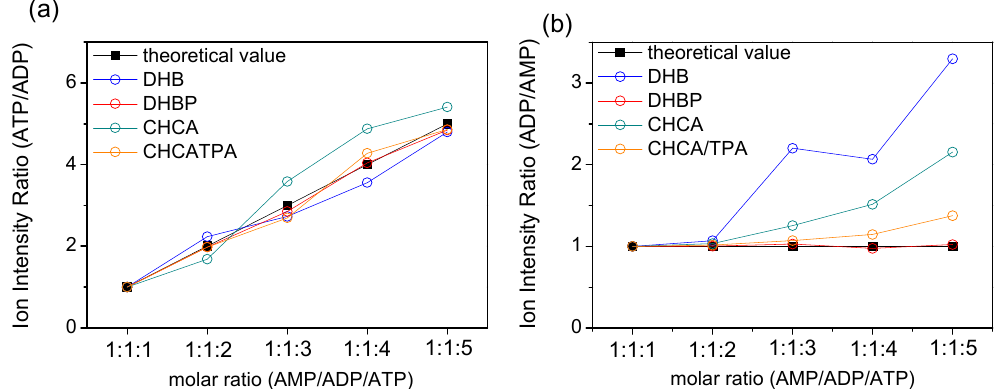
Figure 5. The ion intensity ratios of theoretical and experimental results. The molar ratios were 1:1:1,